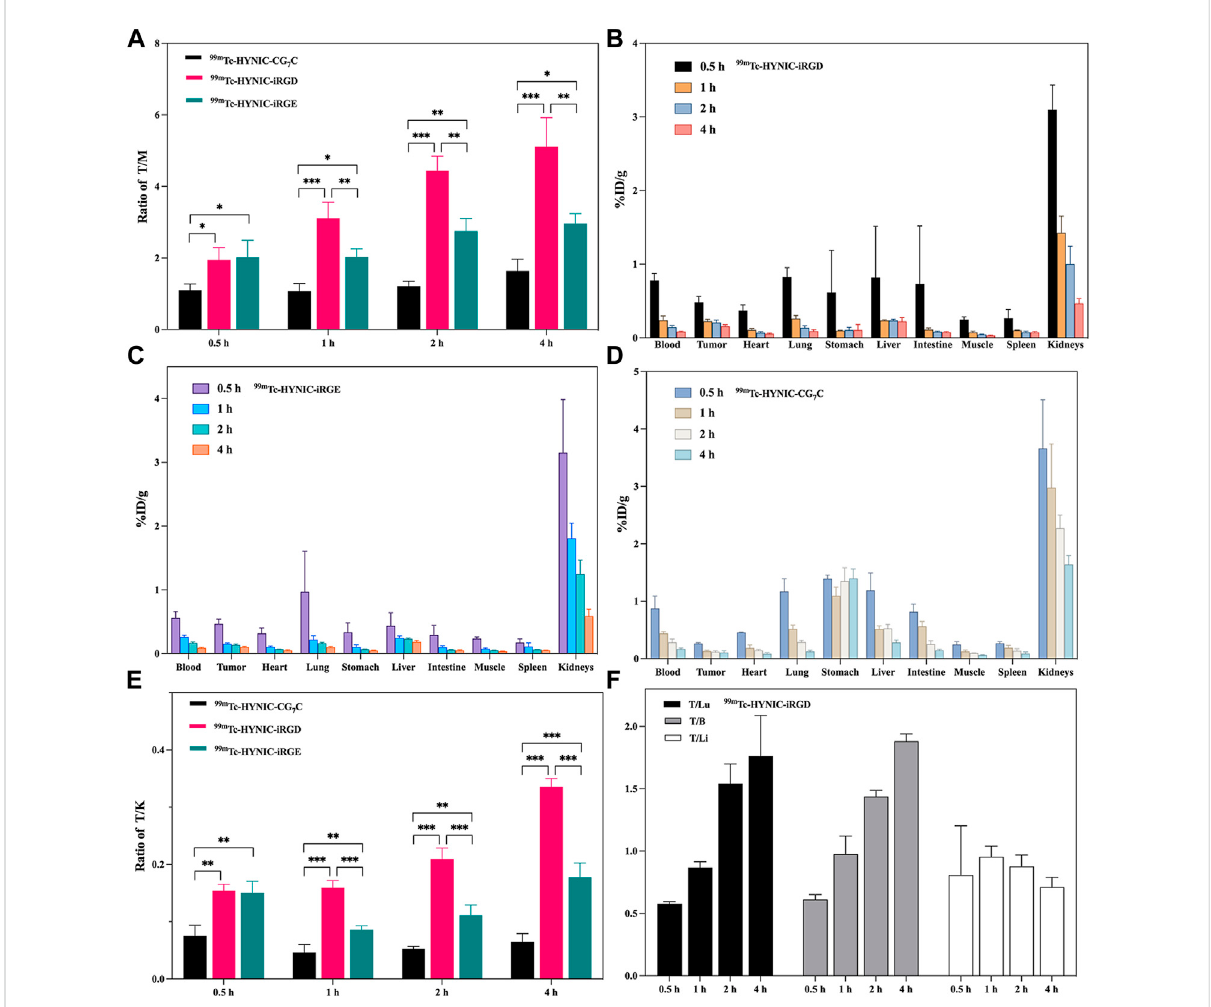
FIGURE 7 (A) TheT/M ratiosof 99m Tc-HYNIC-iRGD, 99m Tc-HYNIC-iRGE, and 99m Tc-HYNIC-CG 7 C at0.5,1,2, and 4 h.Biodistribution of (B) 99m Tc-HYNIC- iRGD, (C) 99m Tc-HYNIC-iRGE and (D) 99m Tc-HYNIC-CG 7 C at 0.5, 1, 2, and 4 h. (E) The T/K ratios of 99m Tc-HYNIC-iRGD, 99m Tc-HYNIC-iRGE, and 99m